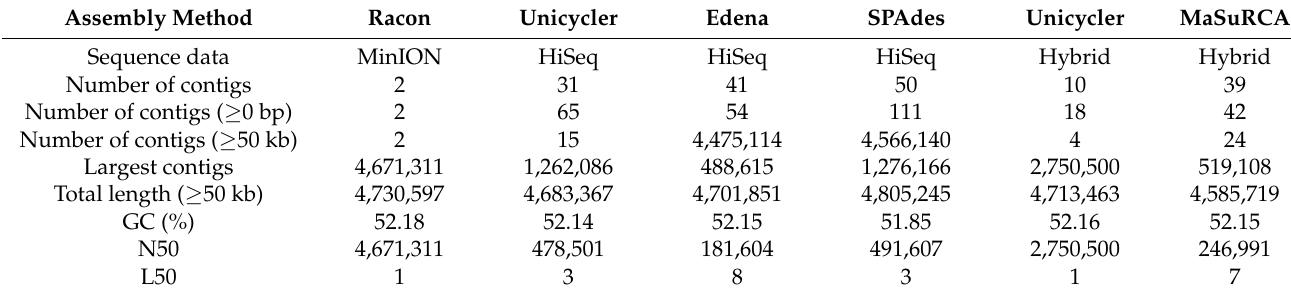
Table 2. Summary statistics for the assembled genome of Salmonella SE3 using reads from Illumina HiSeq and Oxford Nanopore Technologies